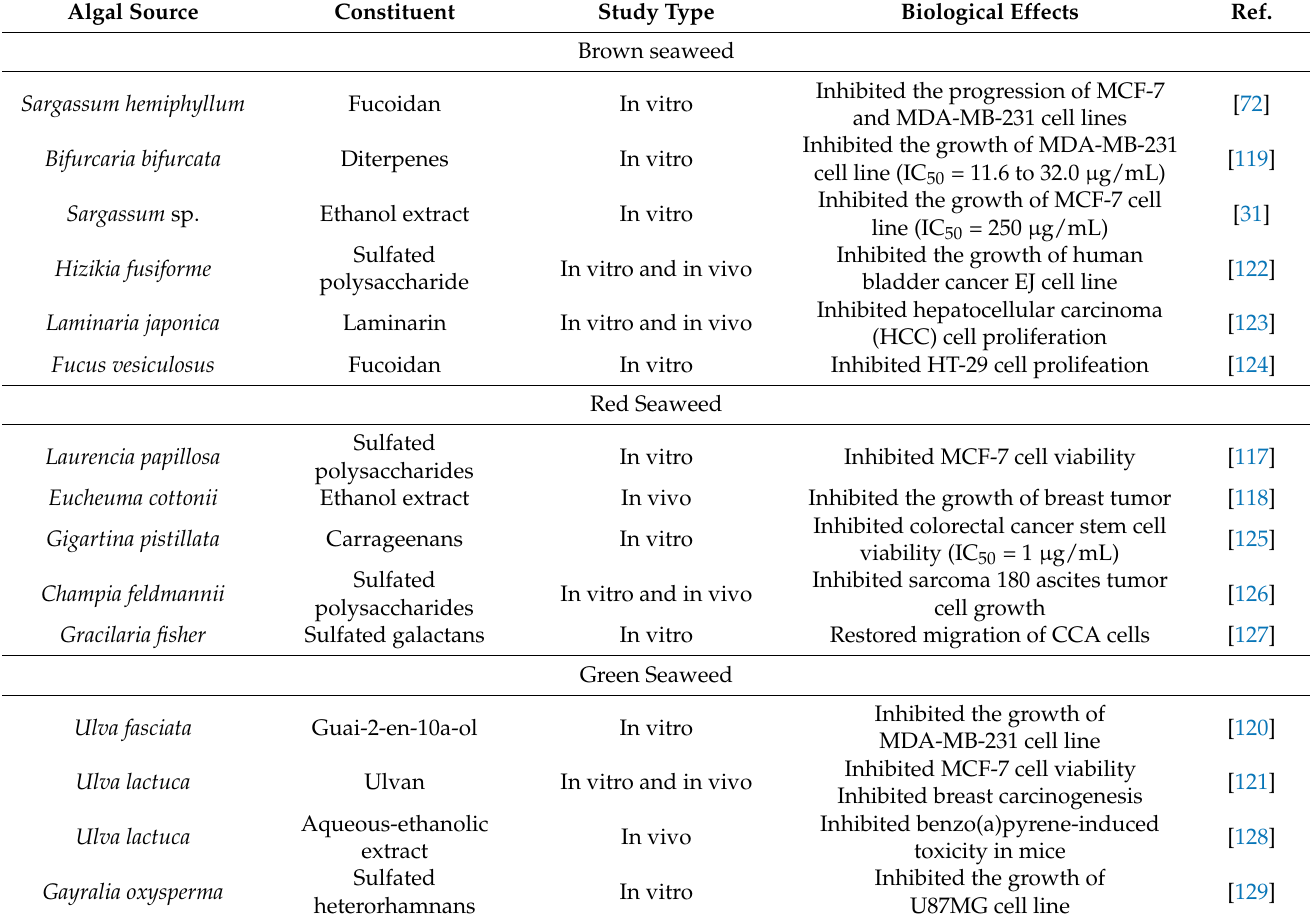
Table 1. The effects of seaweed-derived compounds on